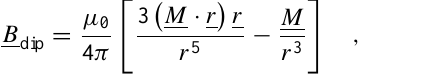
Fig. 1. 3-D simulation geometry – Perpendicular orientation of magnetic moment M and solar wind magnetic field B SW . The obstacle’s center coincides with the center of the cubic simulation domain, its magnetic moment points in ( − z) direction. The up- stream solar wind magnetic field points in ( + y) direction, whereas the undisturbed plasma flow is parallel to the ( + x) axis. Hence, the convective electric field E SW =− V SW × B SW is parallel to M . The plasma enters the simulation domain at the left wall; outflow boundary conditions have been chosen at the other five faces of the simulation